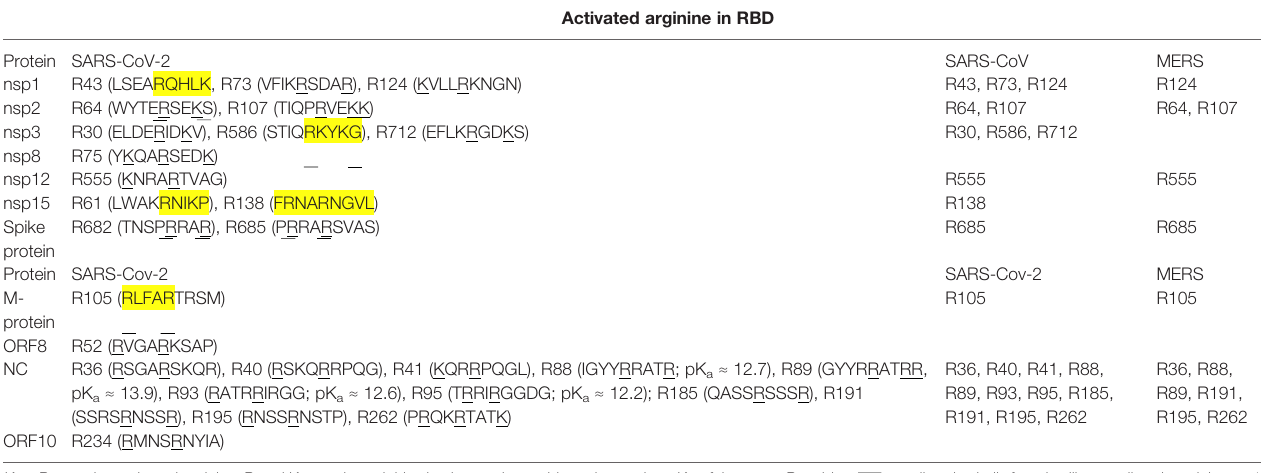
Activated arginine in